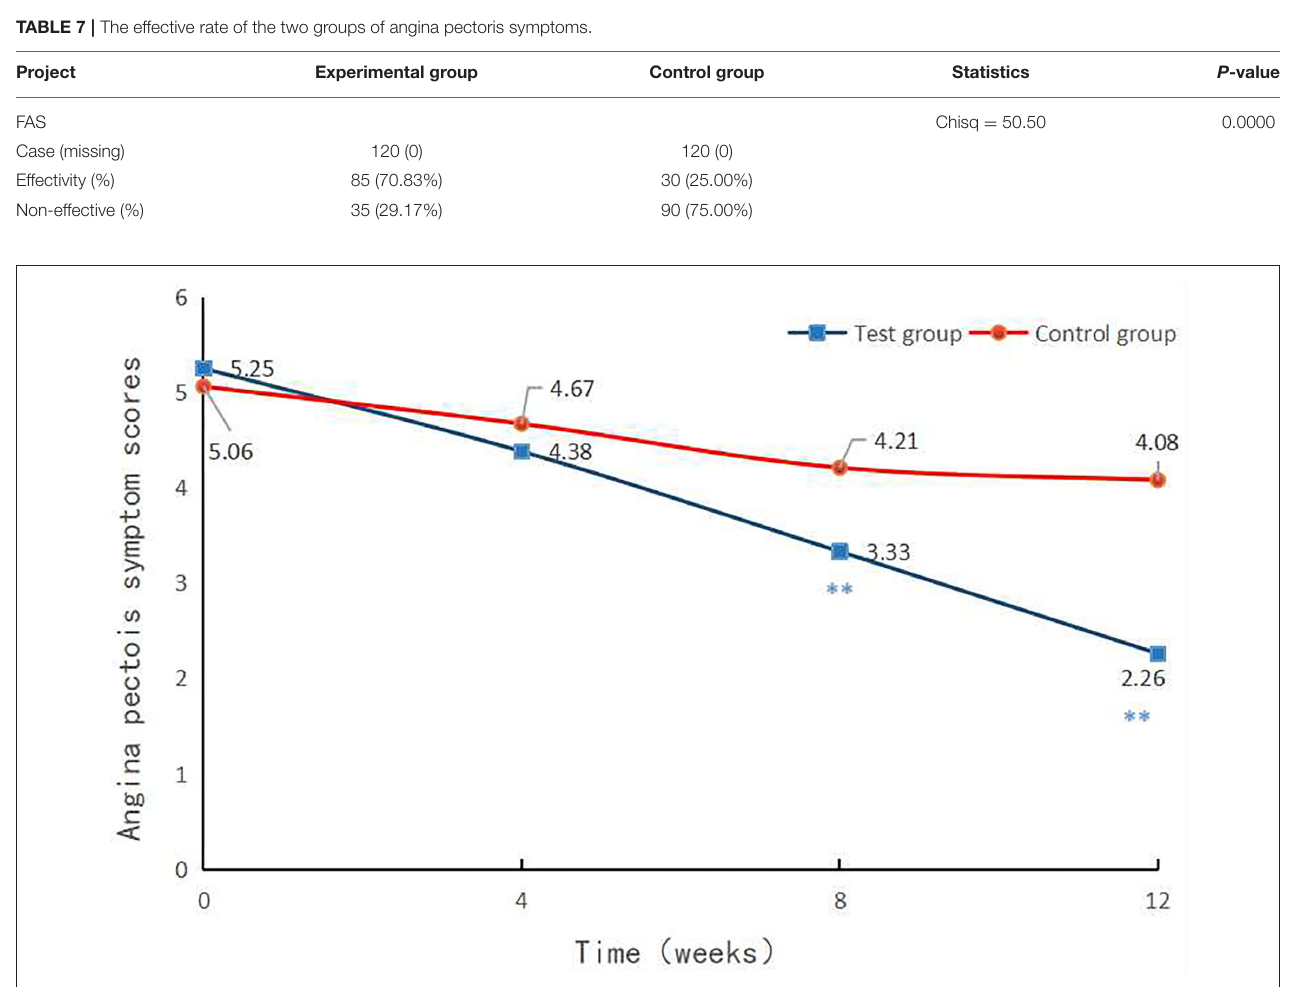
FIGURE 2 | Angina pectoris symptom scores at each visit point. Angina pectoris symptom scores were compared between the two groups at baseline and in the 4th, 8th, and 12th week after treatment. p <